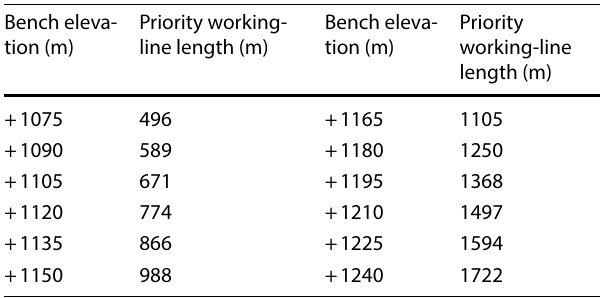
Fig. 12 Diagram of northern priority development scheme in Luzigou anticline region